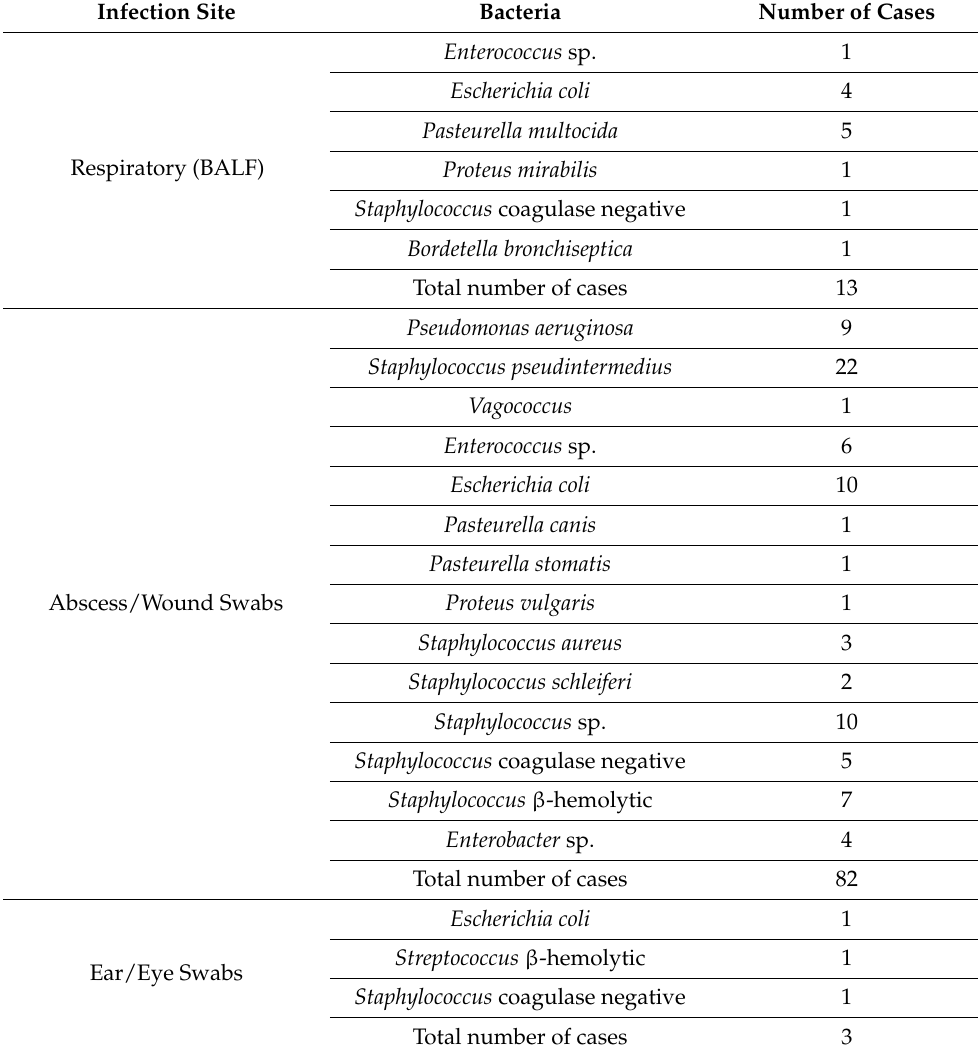
Table 1. Causes of infections by site in dog and cat patients with a cancer